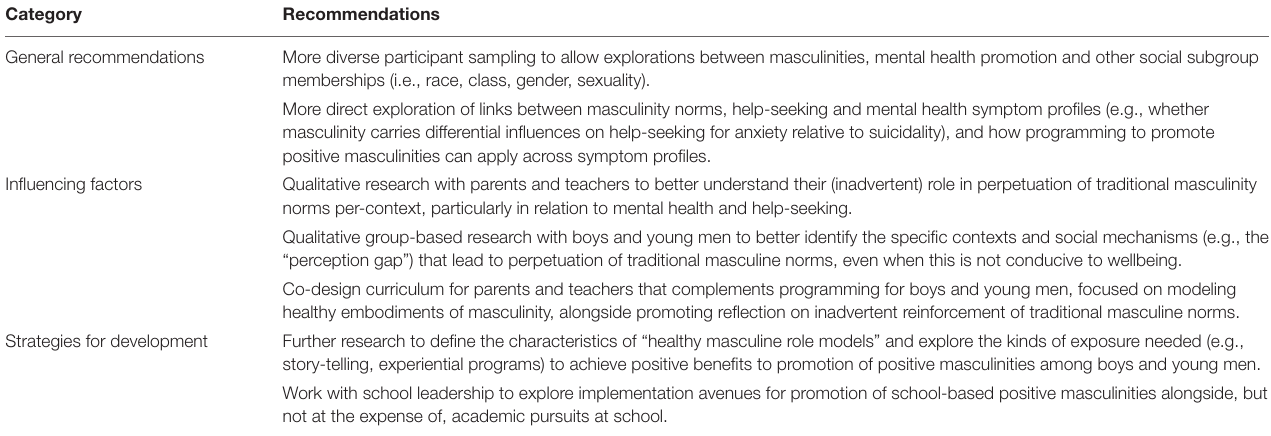
TABLE 3 | Recommendations for future